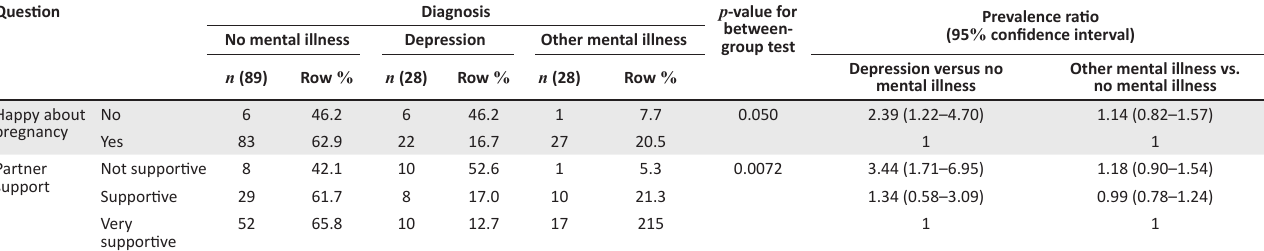
TABLE 1: Association between a diagnosis of depression and feeling happy about pregnancy and partner support.